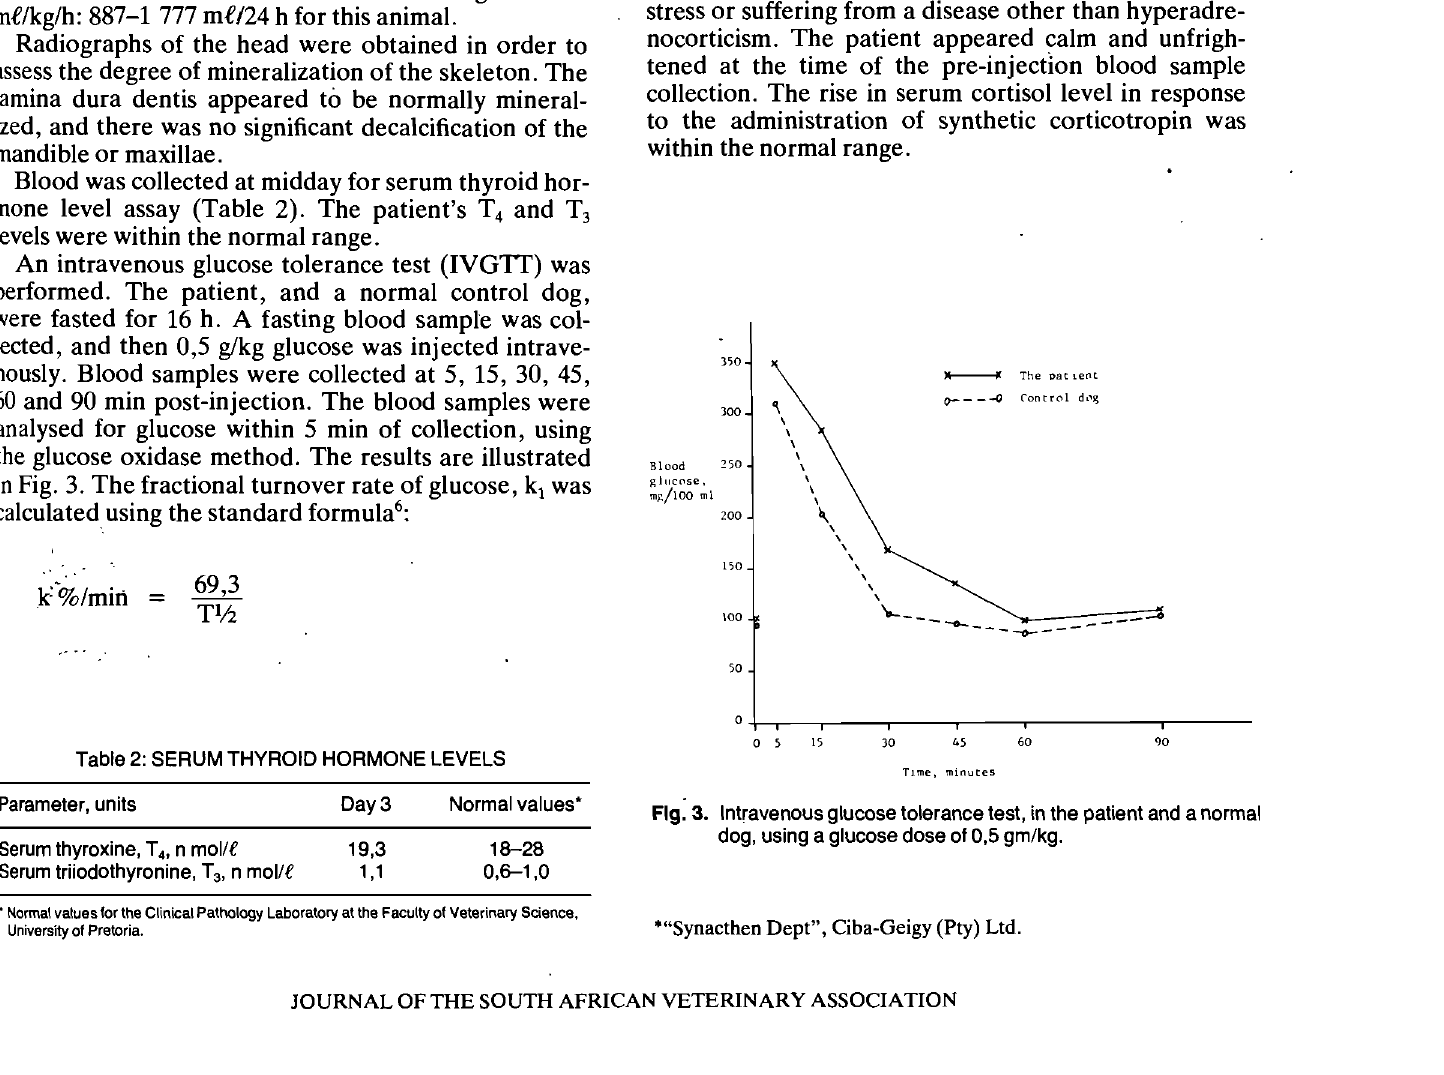
·"Synacthen Dept", Ciba-Geigy (Pty)